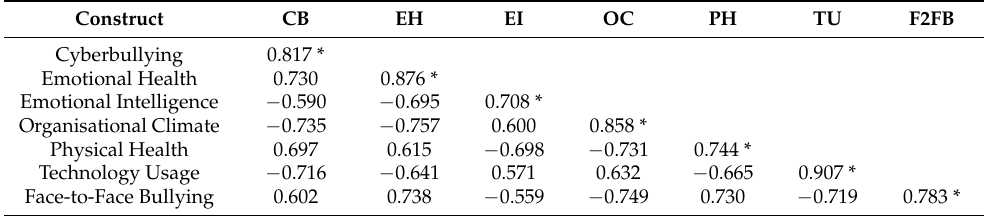
Table 2. Fornell–Larcker criterion.